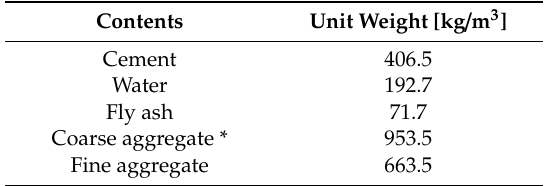
Table 1. Mixture design proportions for the concrete sample.